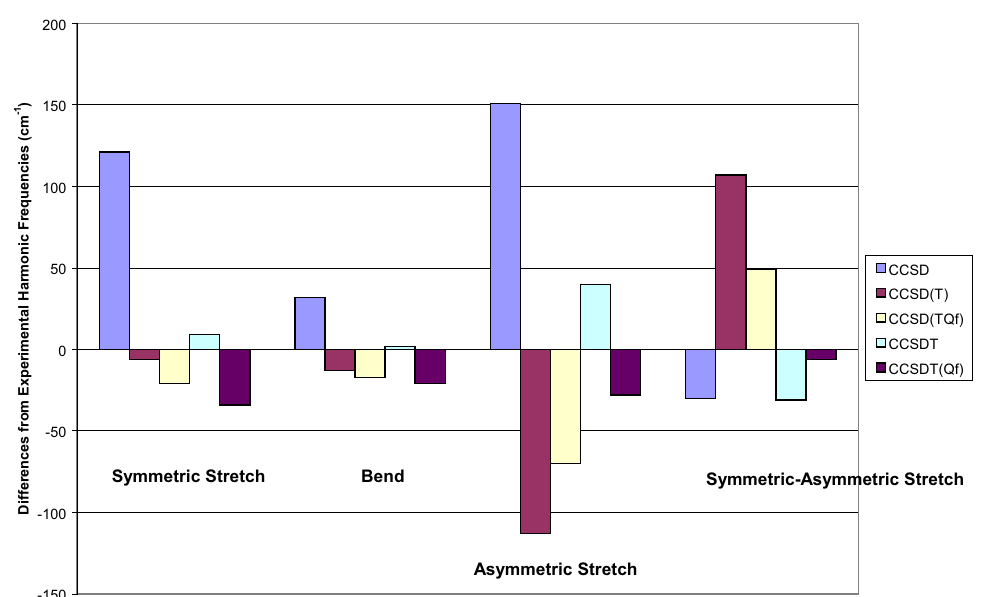
Figure 4: Vibration frequencies of ozone for various single reference methods within a DZP